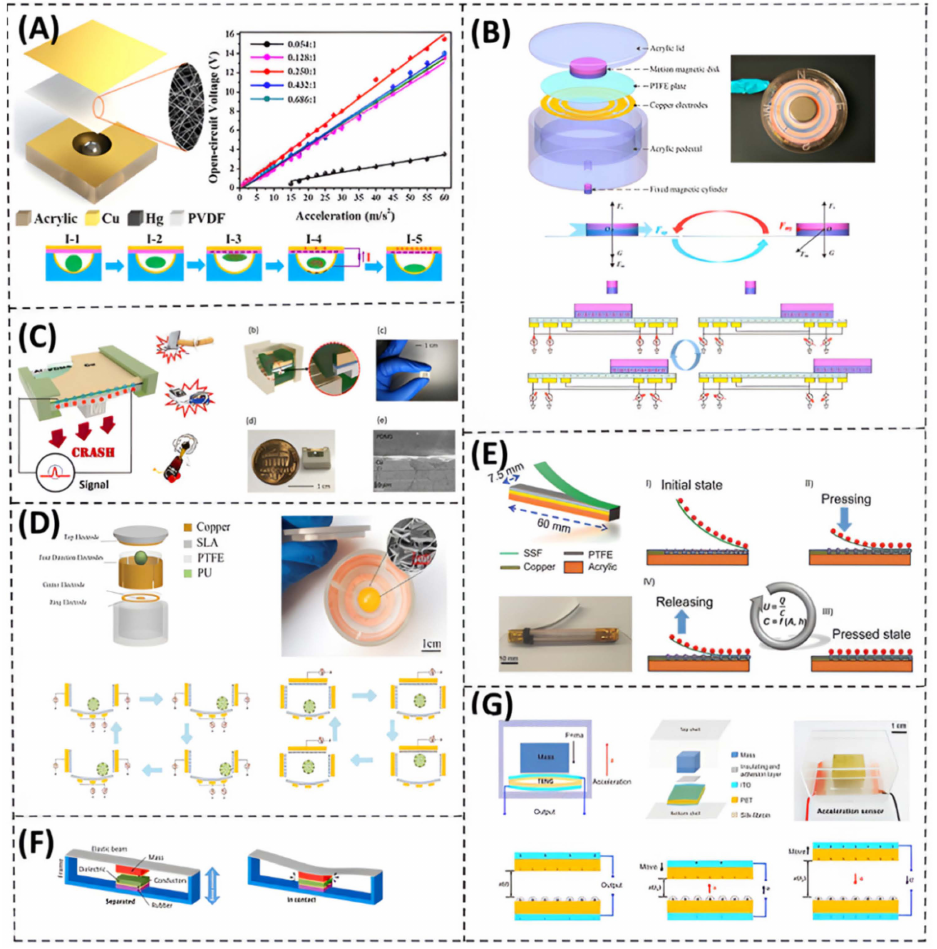
Figure 6. Triboelectric sensors for acceleration measurements. ( A ) Self-powered and extremely sensitive triboelectric acceleration sensor that is made of a liquid metal mercury droplet and a nanofiber-networked polyvinylidene fluoride film (Reprinted with permission [87], copyright 2017, American Chemical Society). ( B ) Self-powered multifunctional triboelectric motion sensor (MFMS), which is capable of concurrently sensing motion characteristics such as direction, speed, and accel- eration of linear and rotating motions (Reprinted with permission [88], copyright 2018, American Chemical Society). ( C ) Self-powered triboelectric high-g acceleration sensor (Reprinted with permis- sion [89], copyright 2017, Elsevier). ( D ) Self-powered multifunctional triboelectric sensor based on PTFE and PU for vibration and motion sensing (Reprinted with permission [90], copyright 2020, John Wiley and Sons). ( E ) Multifunction sensor based on elastic-beam triboelectric nanogenerator. It con- sists of copper and polytetrafluoroethylene layers that are glued on an acrylic plate (Reprinted with permission [91], copyright 2018, John Wiley and Sons). ( F ) Inertial triboelectric motion sensor with optimized parameters (Reprinted with permission [92], copyright 2021, Elsevier). ( G ) Self-powered and high-sensitivity triboelectric acceleration sensor. It is composed of transparent outer shell and inner mass and silk fibroin patches (Reprinted with permission [93], copyright 2019,